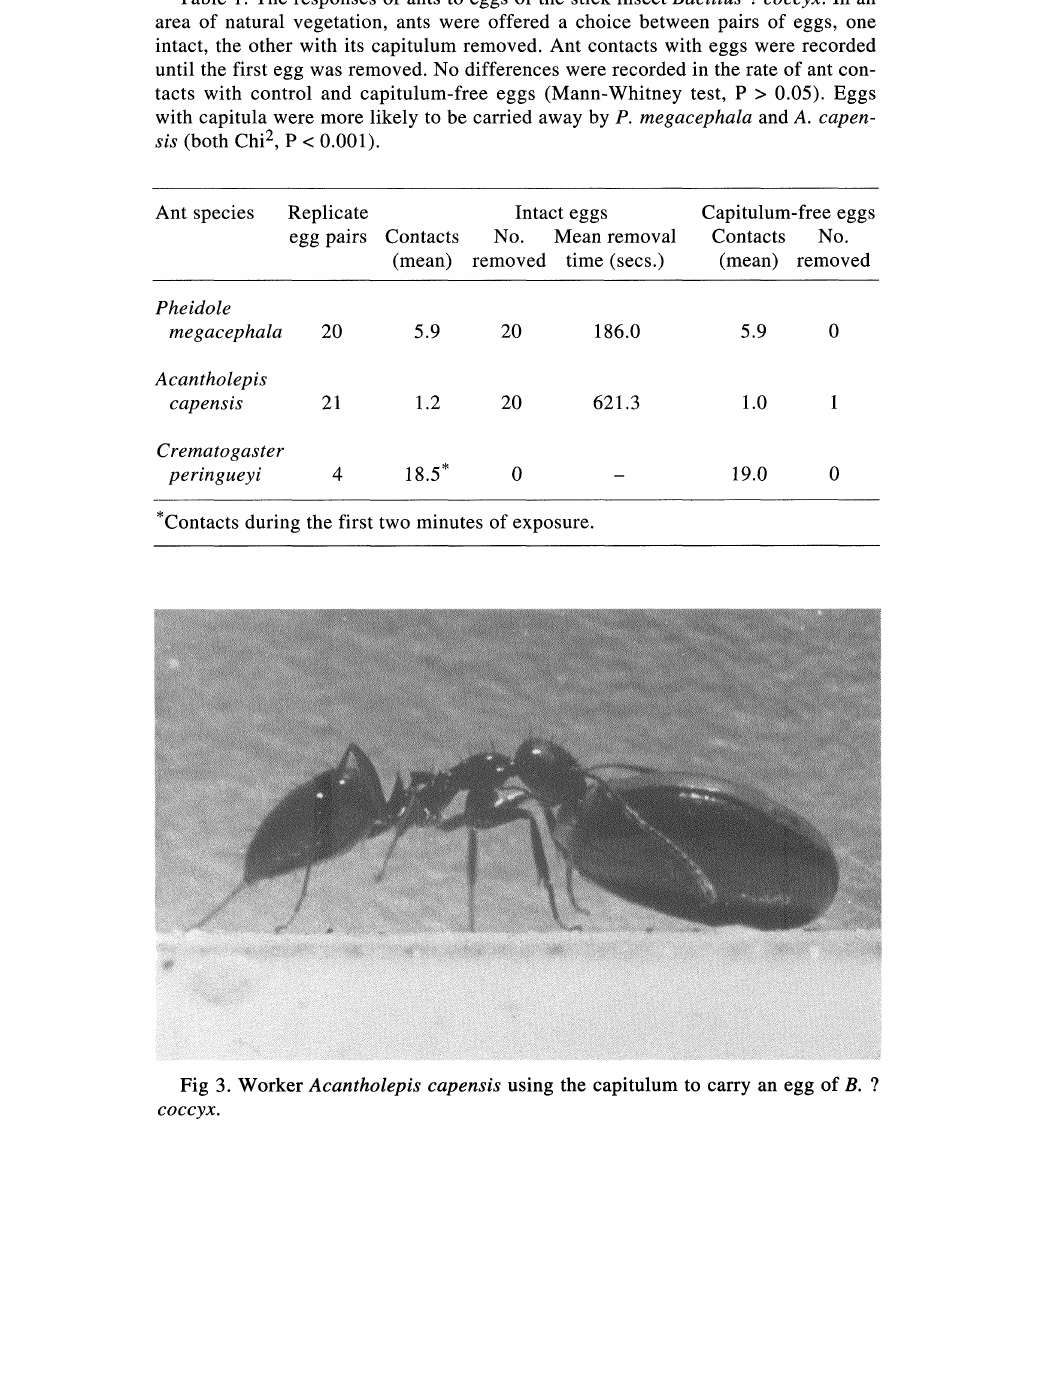
Table 1. The responses of ants to eggs of the stick insect Bacillus ? coccyx. In an area of natural vegetation, ants were offered a choice between pairs of eggs, one intact, the other with its capitulum removed. Ant contacts with eggs were recorded until the first egg was removed. No differences were recorded in the rate of ant con- tacts with control and capitulum-free eggs (Mann-Whitney test, P > 0.05). Eggs with capitula were more likely to be carried away by P. megacephala and A. capen- sis (both Chi 2, P < 0.001).